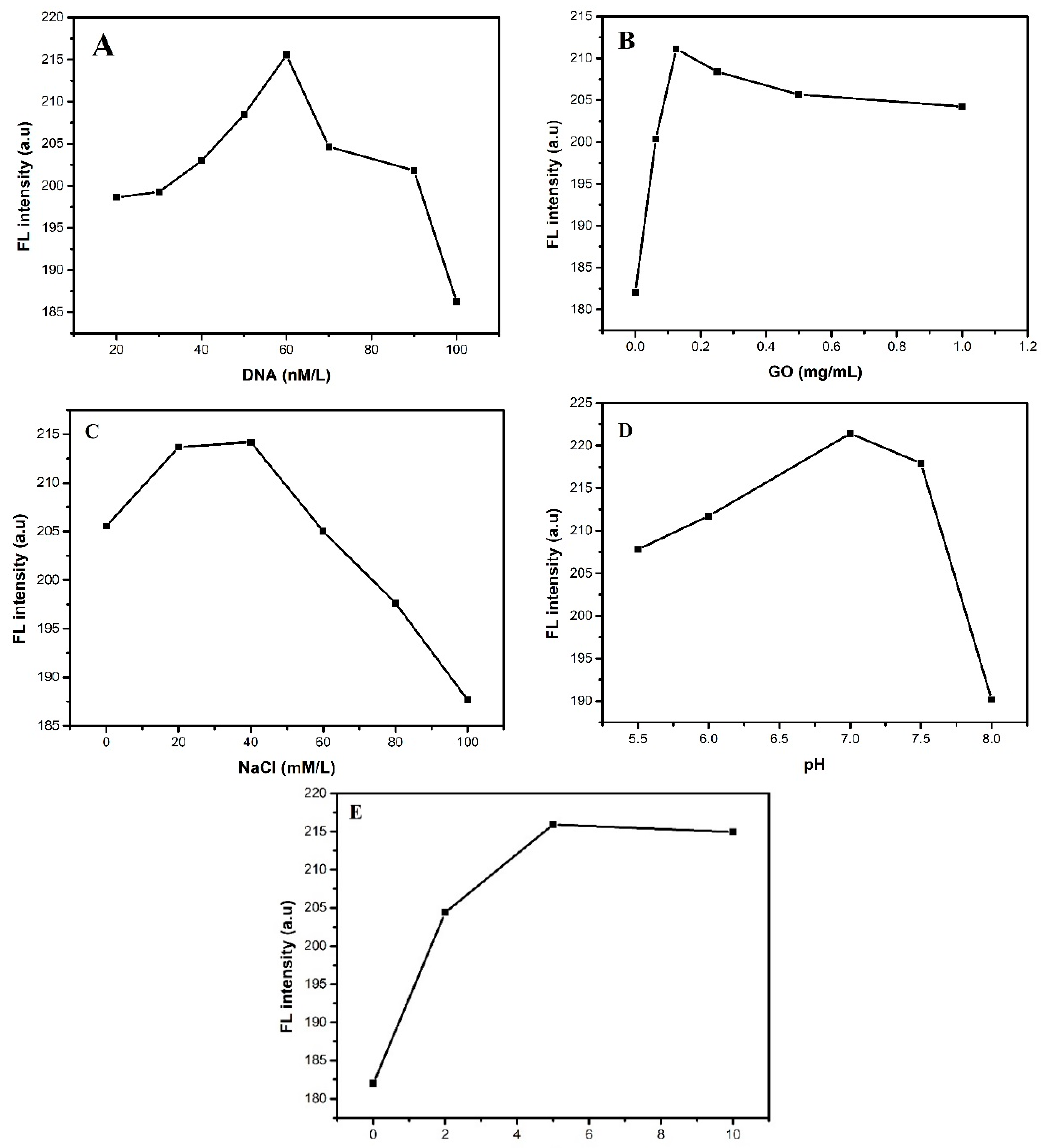
Figure 2. The FL intensity of ( A ) in PBS buffer (50 mmol/L, pH 7.0) containing 40 mmol/L NaCl, 0.125 mg/mL GO, different concentrations of DNA for 5 min; ( B ) in PBS buffer (50 mmol/L, pH 7.0), containing of 40 mmol/L NaCl, different concentration of GO and 60 nmol/L DNA for 5 min; ( C ) in PBS buffer (50 mmol/L, pH 7.0) containing different concentration of NaCl, 60 nmol/L DNA, 0.125 mg/mL GO; ( D ) in PBS solutions (50 mol/L) with different pH values containing 40 mmol/L NaCl, 60 nmol/L DNA, 0.125 mg/mL GO for 5 min; ( E ) in PBS solution (50 mmol/L, pH 7.0) containing 40 mmol/L NaCl, 60 nmol/L DNA and 0.125 mg/mL GO for various time.